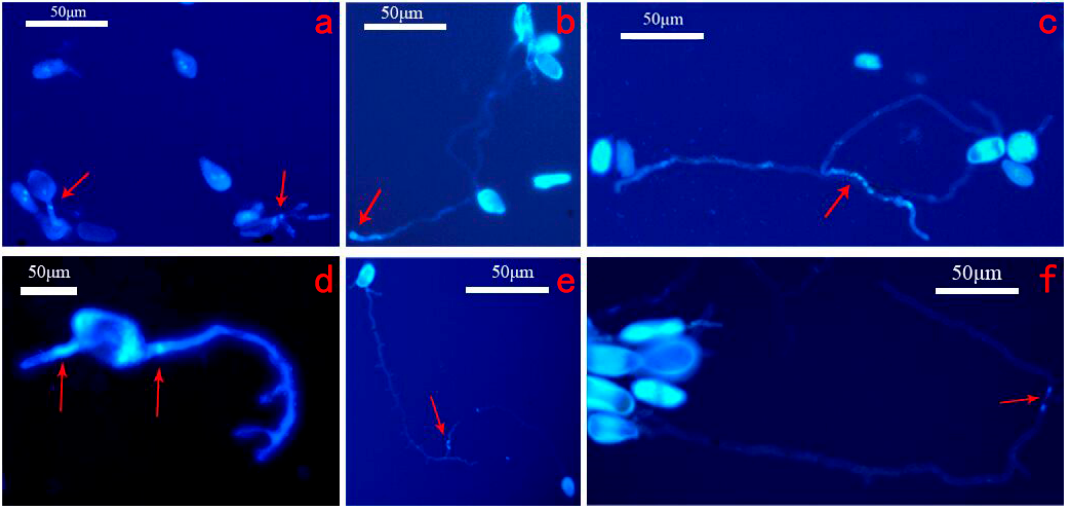
Figure 3. Germination of urediniospores of M. medusae and M. larici-populina on a medium of 2% agar. ( a – c ) M. medusae ; ( d – f ) M. larici-populina ; ( a ) the flowing nuclei (arrows) after 6 h; ( b ) the swollen top of the germ tube (arrows) after 10 h; ( c ) germ nucleates (arrows) with 4 nucleates after 16 h; ( d ) the flowing nuclei of MLP (arrows) after 8 h; ( e ) the germ tube with 2 nuclei (arrows) after 10 h; ( f ) the germ tube with 2 nuclei (arrows) after 16 h.